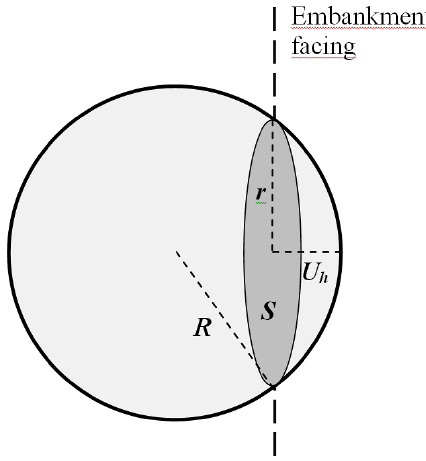
Figure 5. Definition of the contact surface between the projectile and the